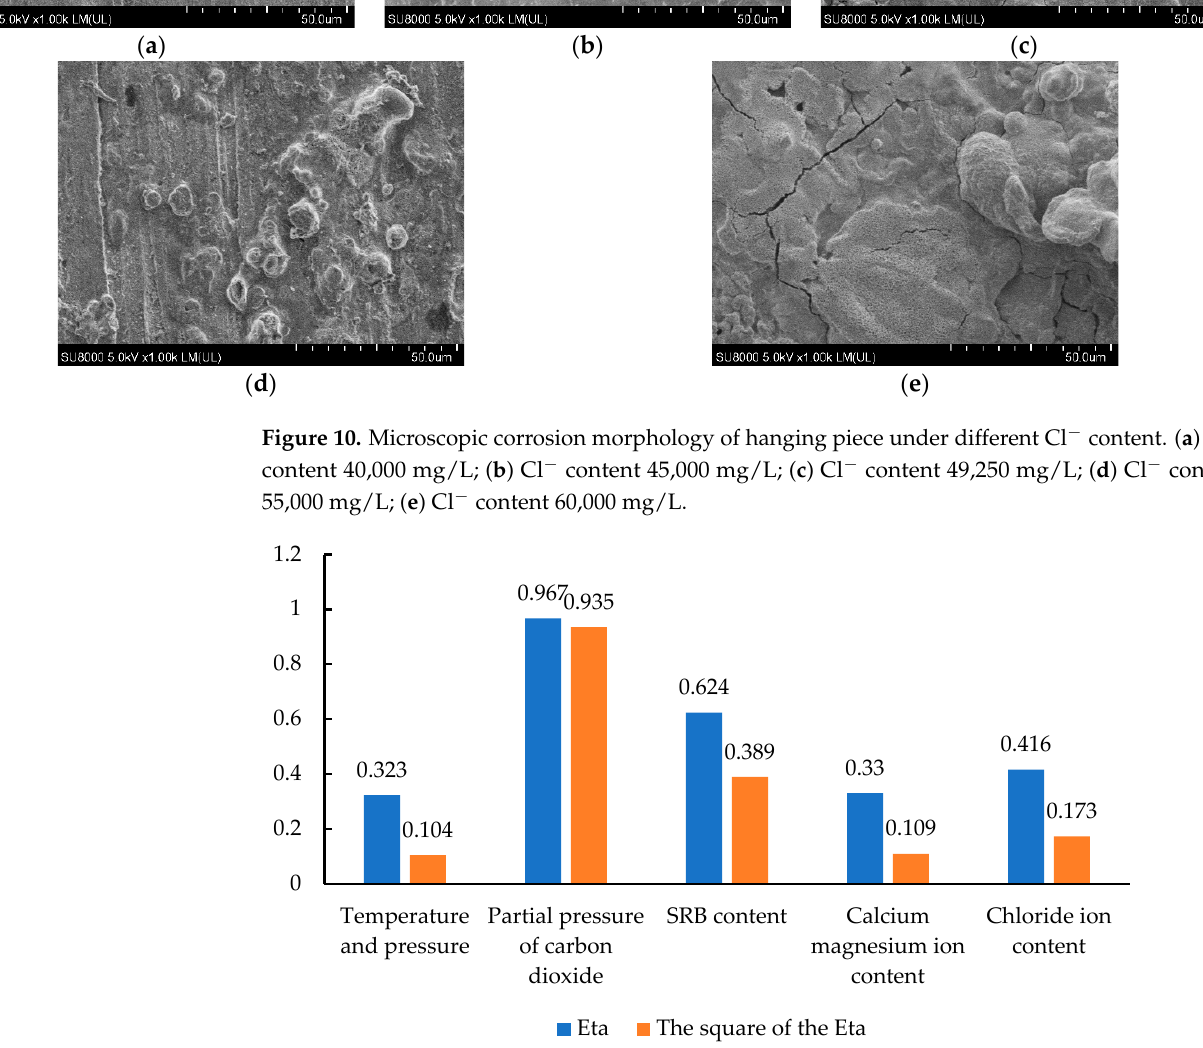
Figure 11. SPSS data analysis results.